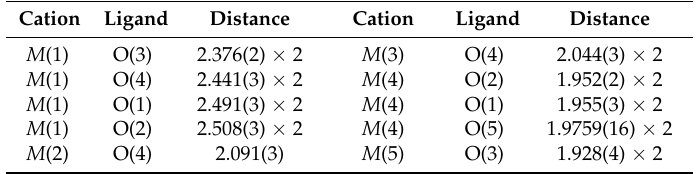
Table 6. Selected interatomic distances (Å) in the structure of nöggerathite-(Ce). Cation